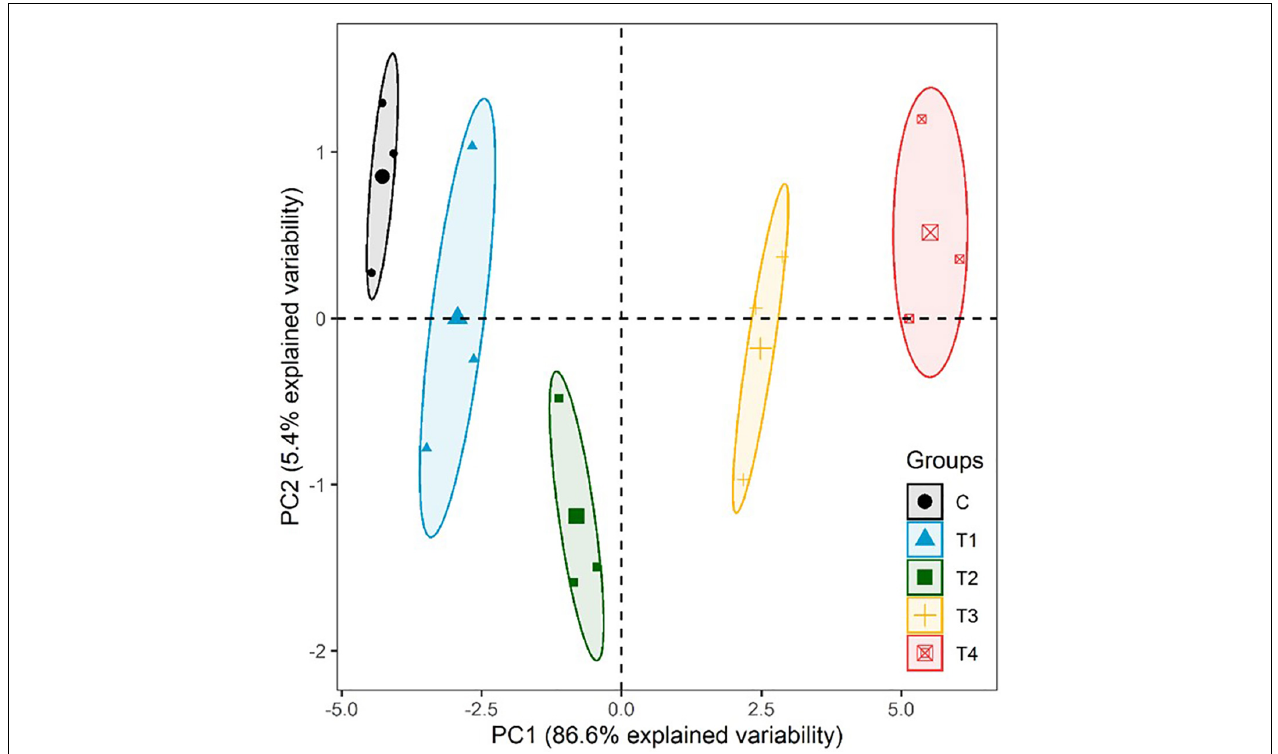
FIGURE 11 | PCA scatter plot with centroids and 95% confidence ellipses. Principal components were derived from all tested parameters and treatments. C, 0 mM NaCl; T1, 40 mM NaCl; T2, 80 mM NaCl; T3, 160 mM NaCl; T4, 240 mM